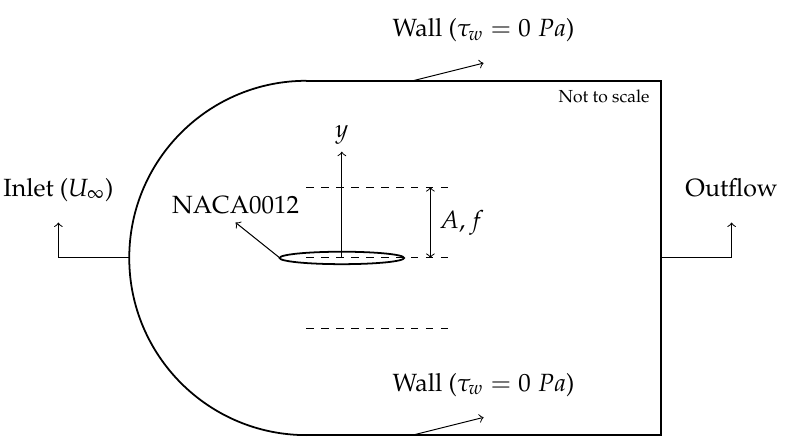
Figure 2. Computational domain [5].